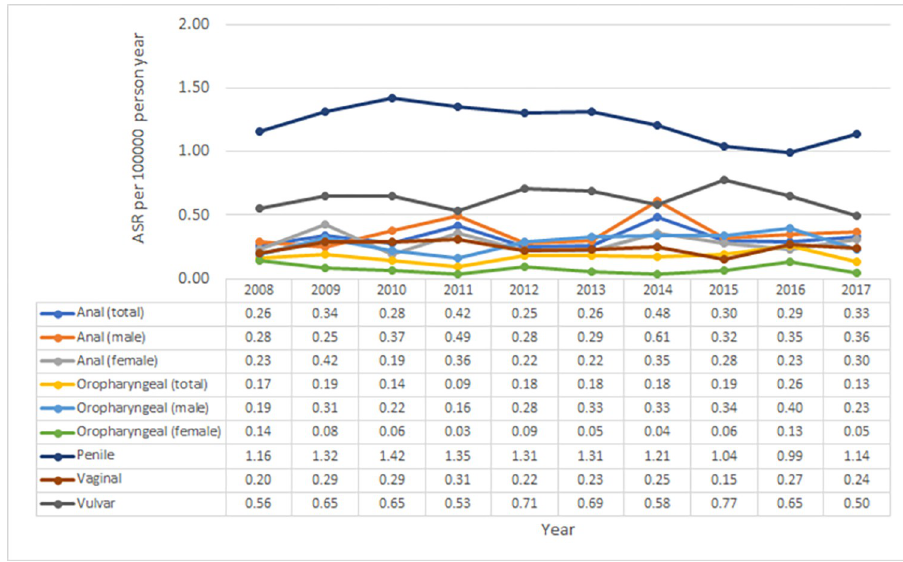
Fig 3. Trends in the incidence of non-cervical HPV-related